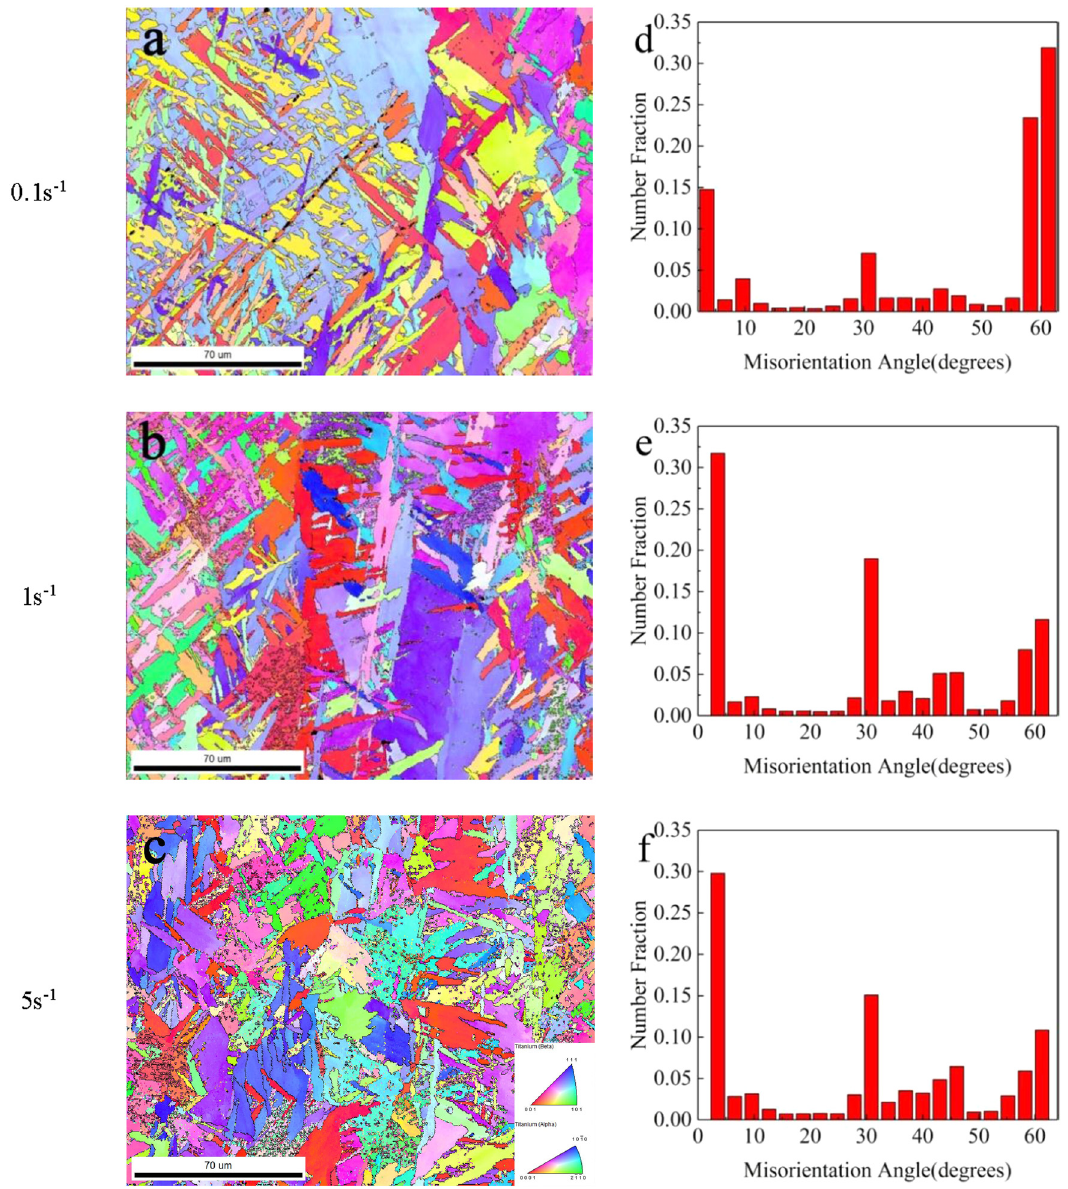
Figure 11: Inverse pole fi gure of the samples at the deformation of two - pass: ( a ) 0.1 s − 1 , ( b ) 1 s − 1 , ( c ) 5 s − 1 , misorientation angles of the samples at the deformation of two - pass: ( d ) 0.1 s − 1 , ( e ) 1 s − 1 and ( f ) 5 s − 1